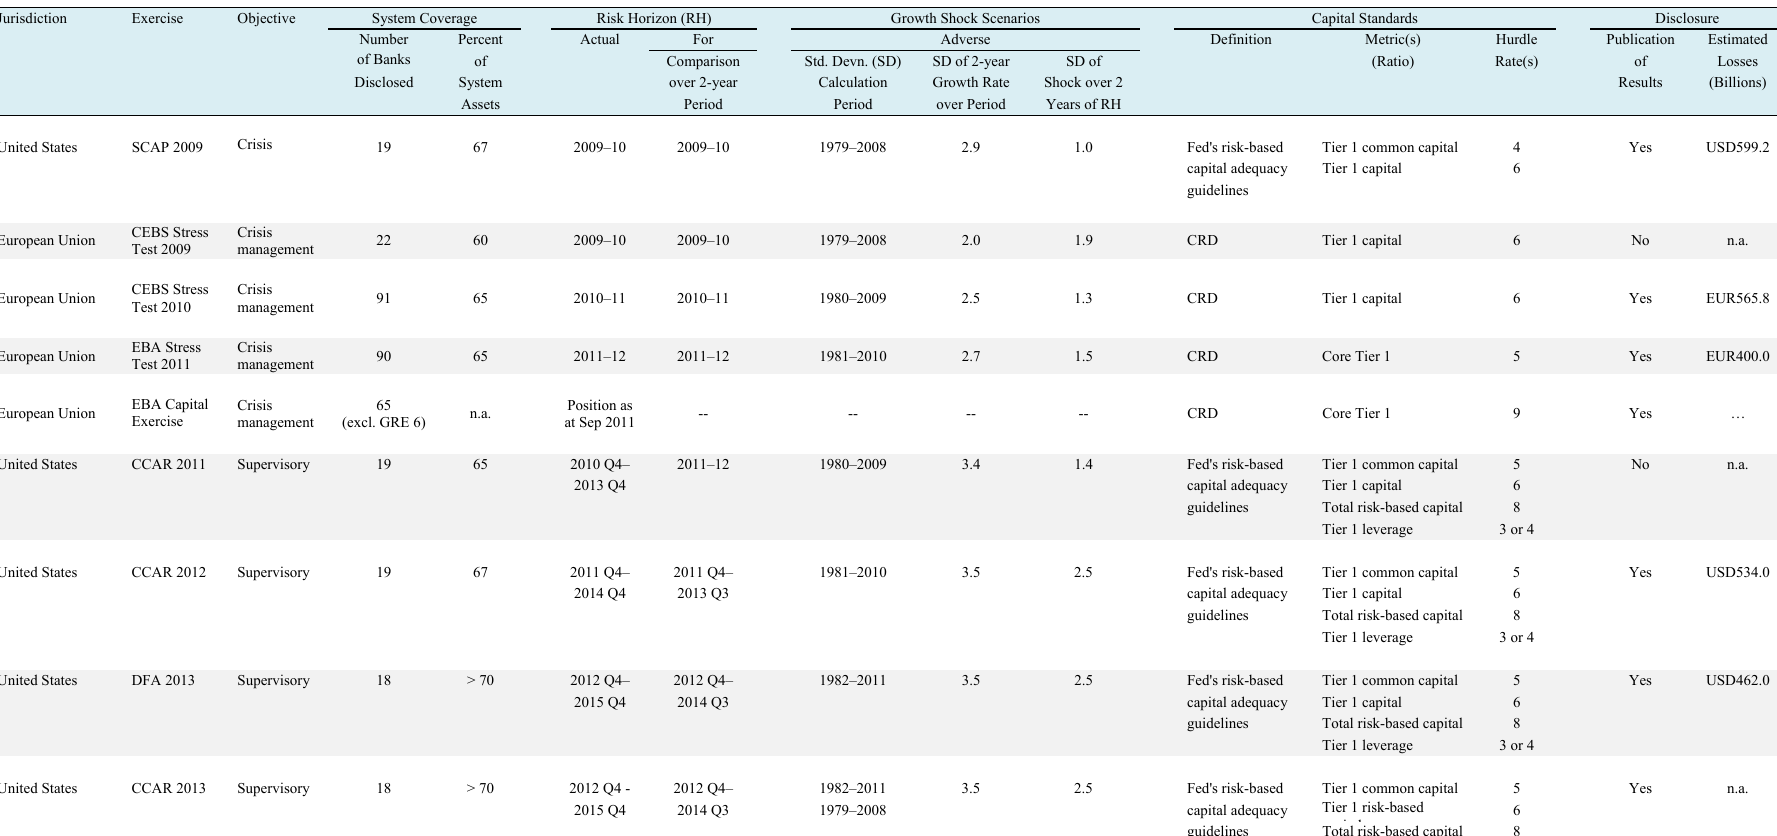
Table 10. European Union and the United States: Evolution of Publicized Stress Testing